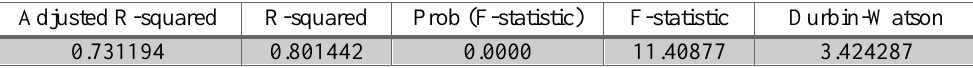
Table 6. Other results of fixed effects- Model Number